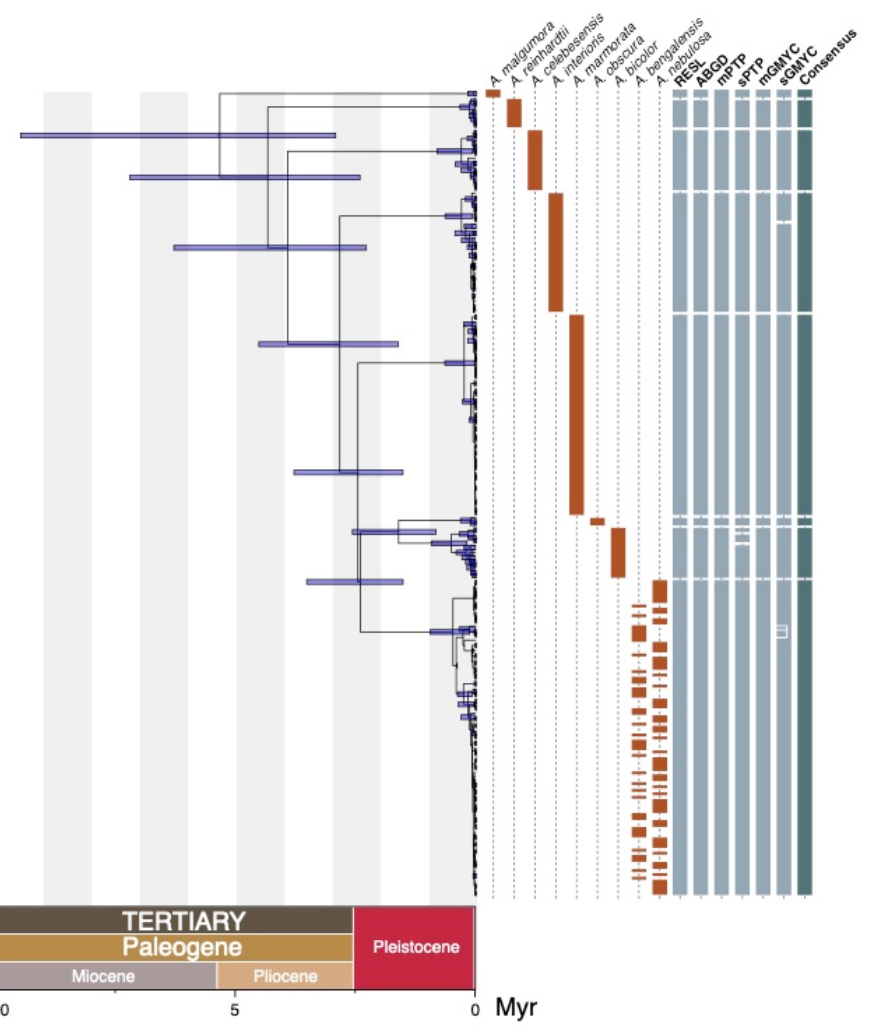
Figure 3. Mitochondrial gene tree of Anguilla spp. inferred with SpeciesTreeUCLN, including 95% HPD interval for node age estimates, species boundaries according to morphology-based identifications, and genetic species delimitation results for six methods and their 50% consensus.